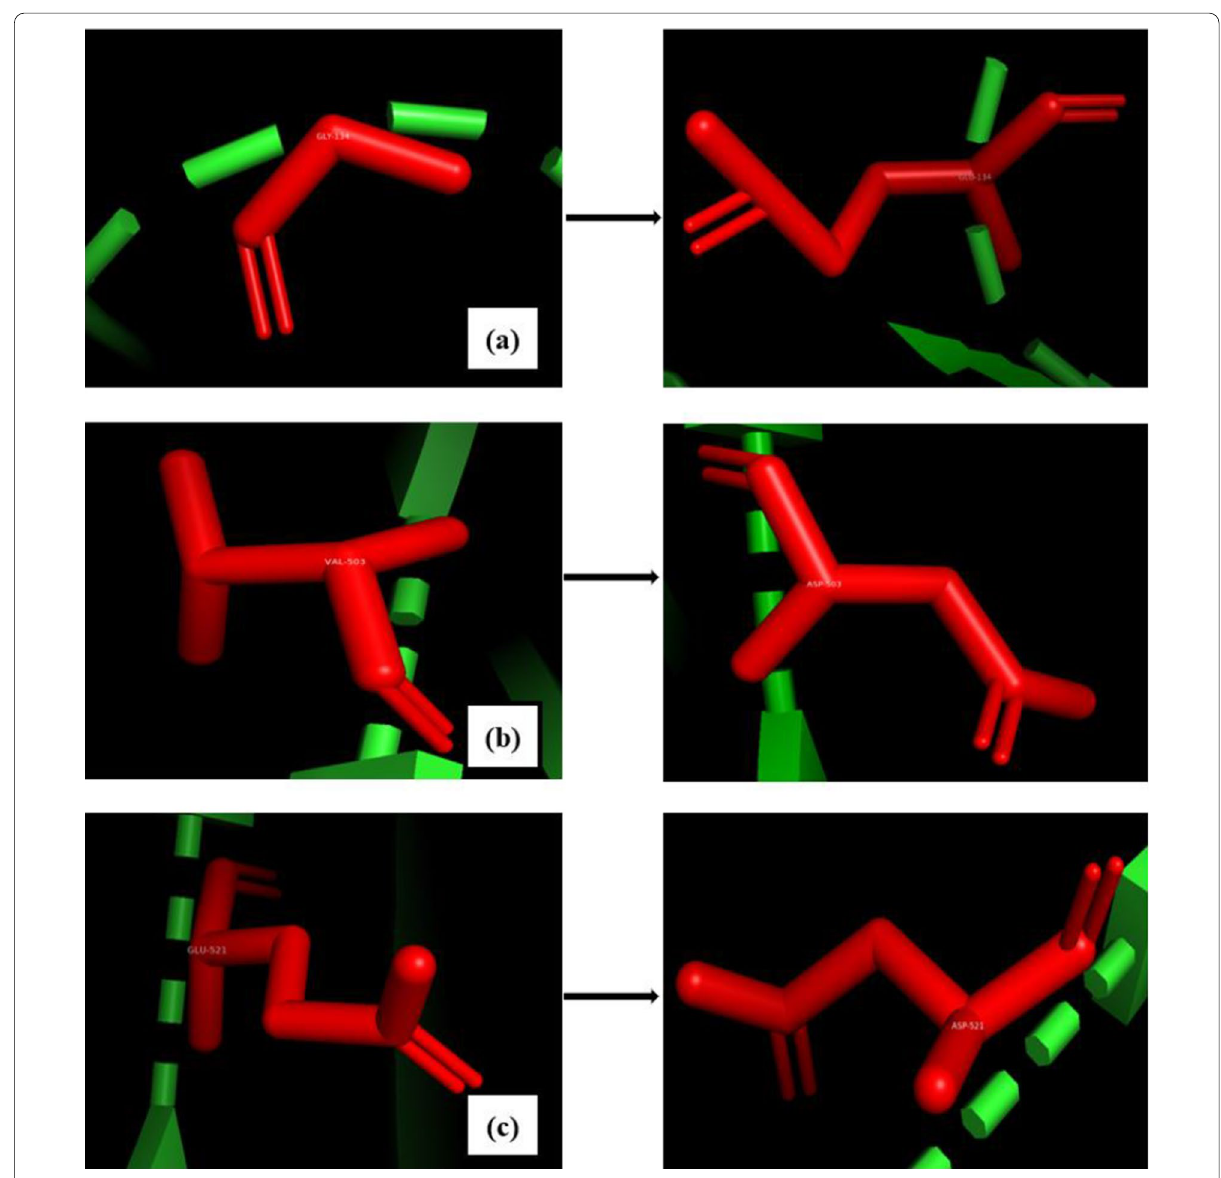
Fig. 3 Comparison of native (left) and mutant (right) structure using PyMol. a G134E, b V503D and c